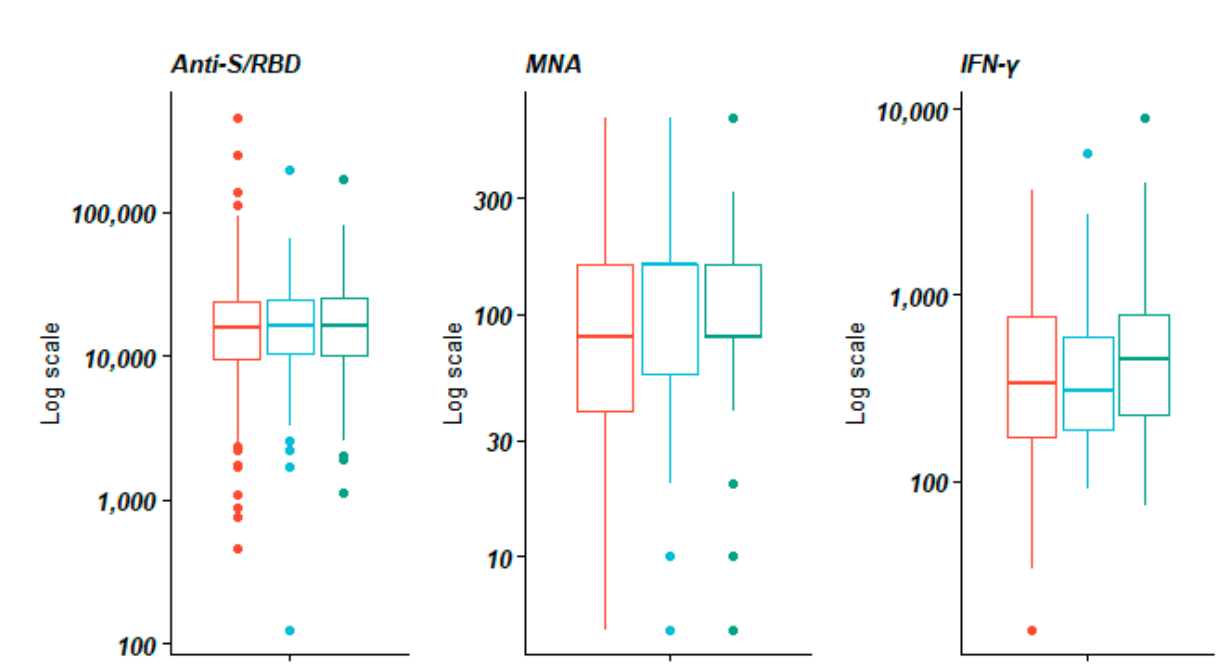
Figure 2. Title: Anti-S/RBD, MNA, and IFN- γ titers elicited by the BNT162b2 SARS-CoV-2 vaccine according to the in- fluenza/pneumococcal vaccination. Legend: Anti-S/RBD: anti-Spike receptor-binding domain; MNA: Micro-neutralization assay titers; IFN: interferon Red: No influenza and pneumococcal vaccine; Light blue: Only influenza vaccine; Green: Influenza and pneumococcal vaccine. Bold line: median value. Table 2. Multiple regression with log-transformed anti-S/RBD, MNA, and IFN- γ titers elicited by BNT162b2 vaccine according to studied